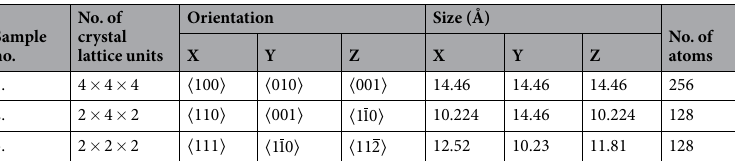
Table 3. Necessary details of the initial configurations of the samples with desired orientations used for ab − initio molecular dynamics (AIMD). The mass density of all the samples are 8.814 g/cm 3 at ambient temperature and